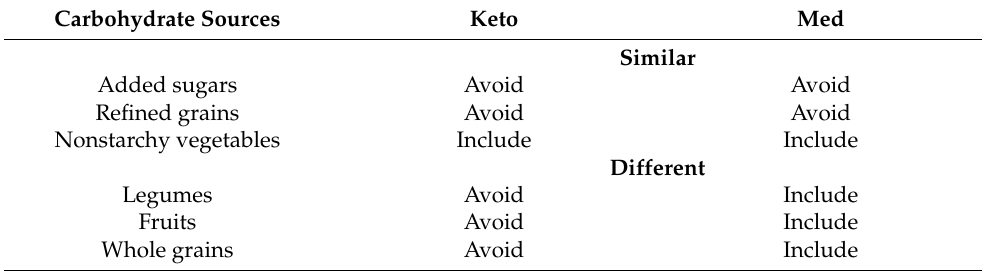
Table 1. Key Similarities and Differences for the Two Keto–Med Randomized Trial Diet Patterns. Carbohydrate